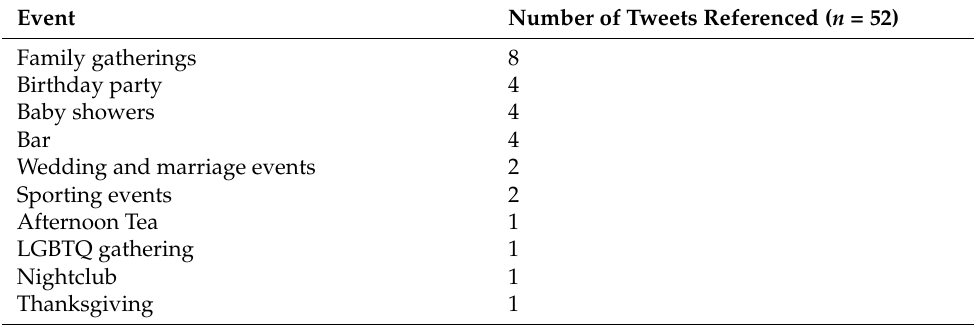
Table 3. Social gatherings, events, and